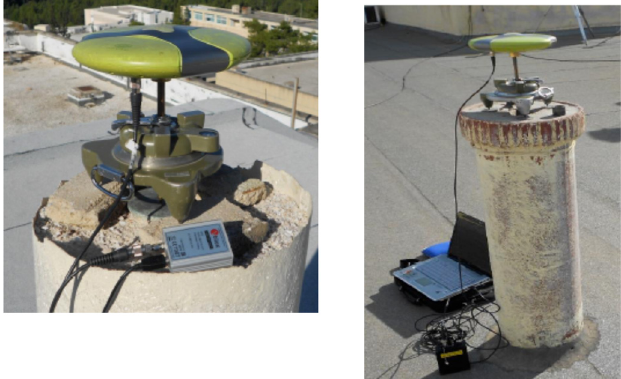
Fig. 1. Receiver con fi guration using the low-cost receivers (u-blox LEA-6T and NEO-7P) connected to geodetic antennas.